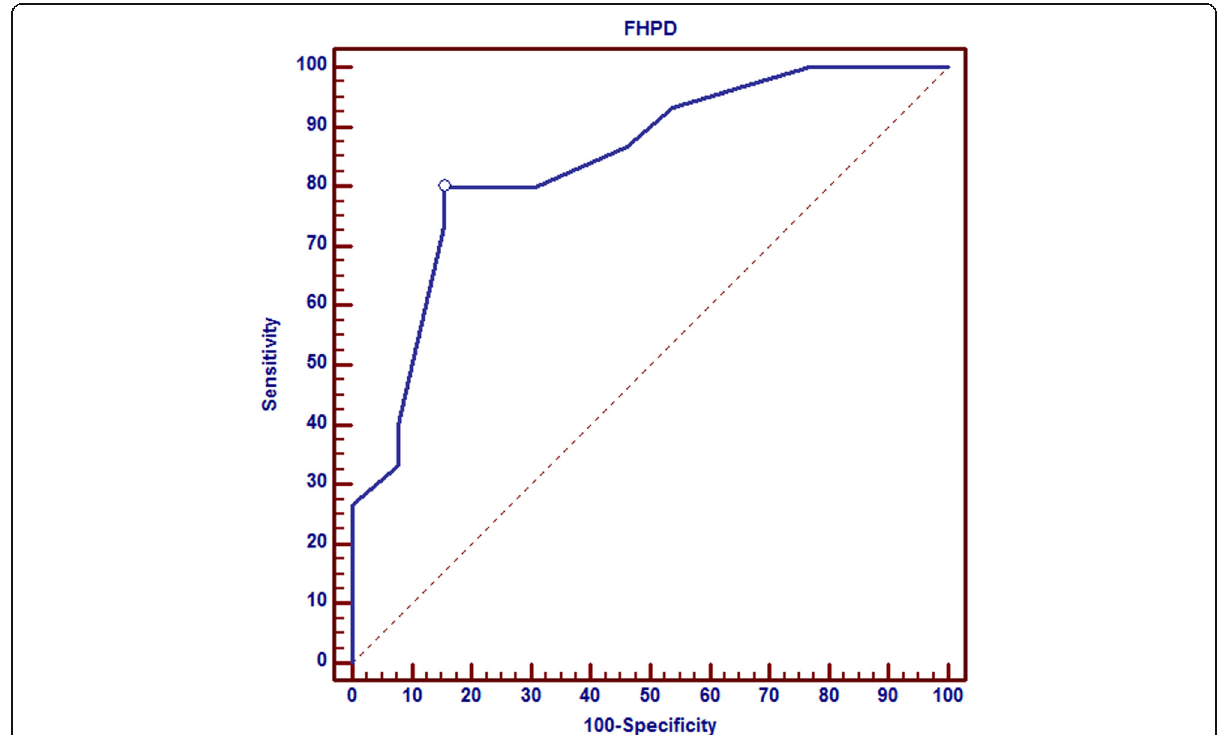
Fig. 9 ROC curve that shows the prediction of vaginal delivery by